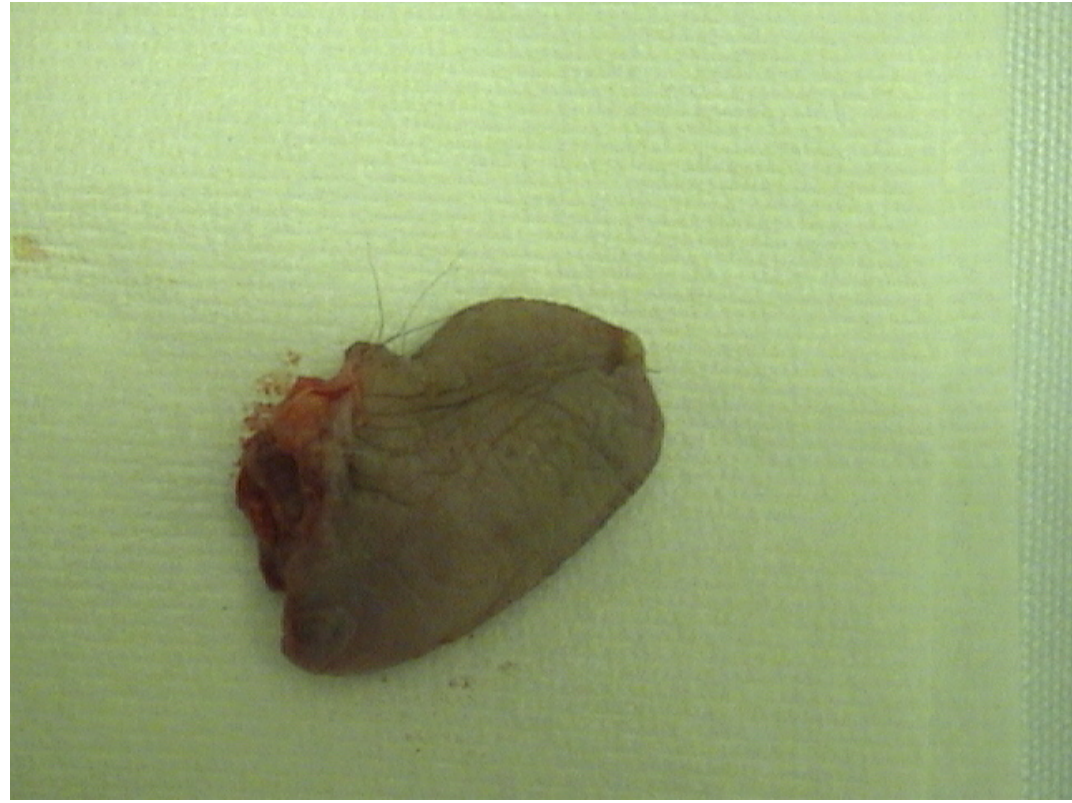
FIGURE 1. Macroscopic picture of excised ciliated perianal median raphe